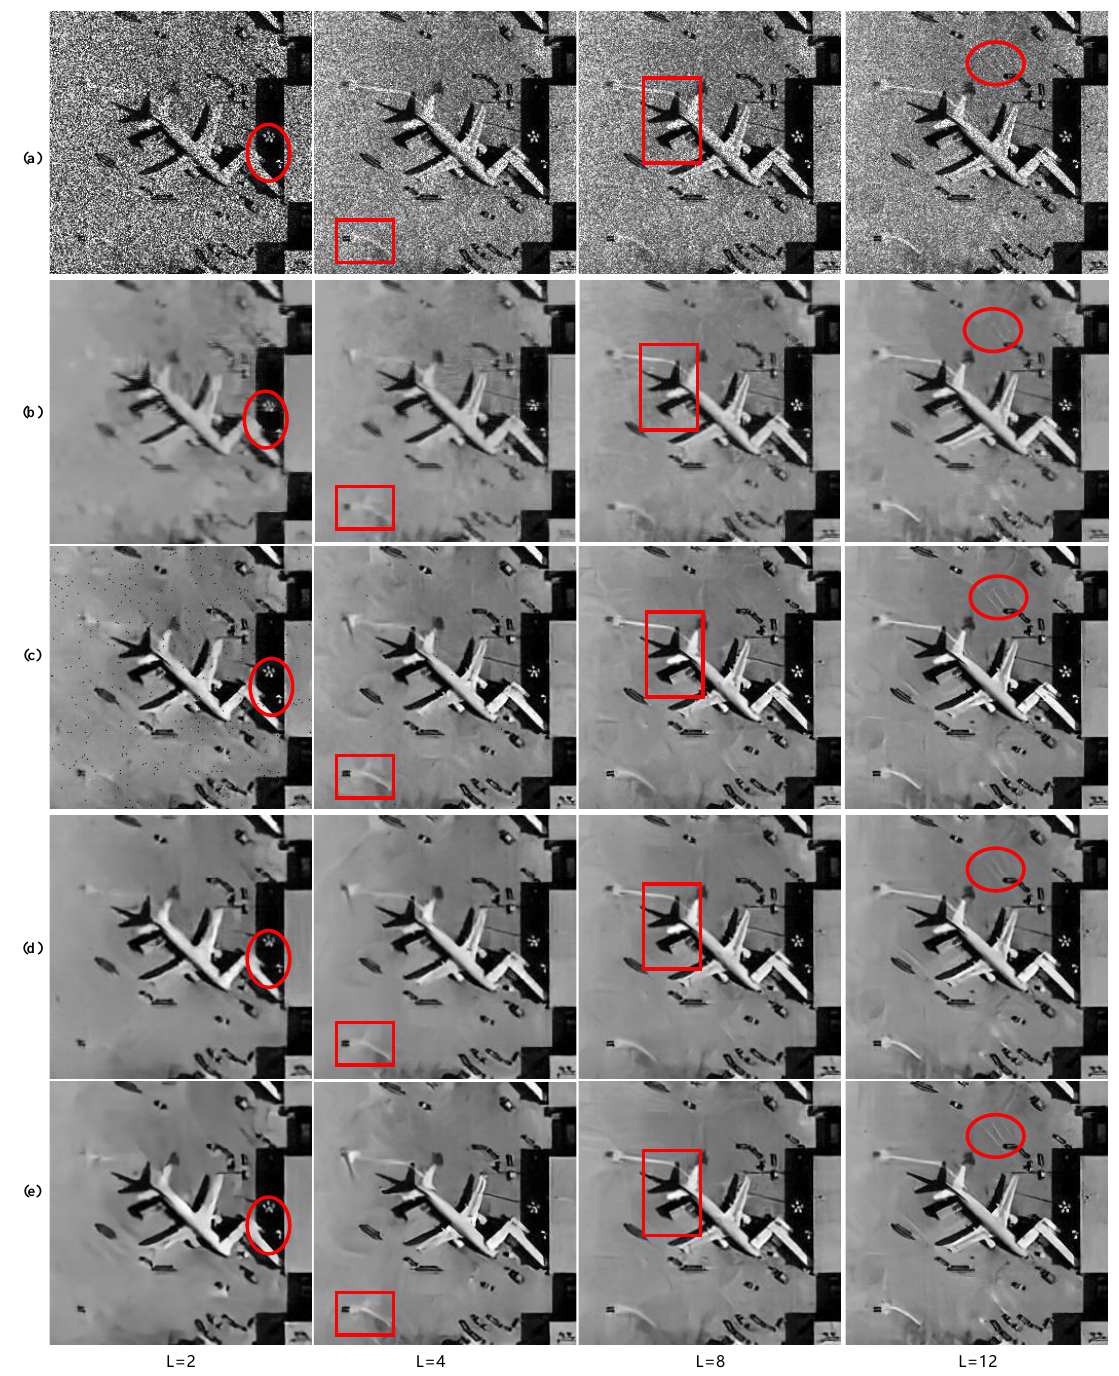
Figure 8. Test results on images of airplanes with four levels of noise. The noise level from left to right is L = 2, L = 4, L = 8, and L = 12. ( a ) Speckled image ( b ) SAR-BM3D (Block-Matching and 3D filtering) ( c ) image despeckling convolutional neural network (ID-CNN) ( d ) RED-Net ( e ) multi-scale recurrent network